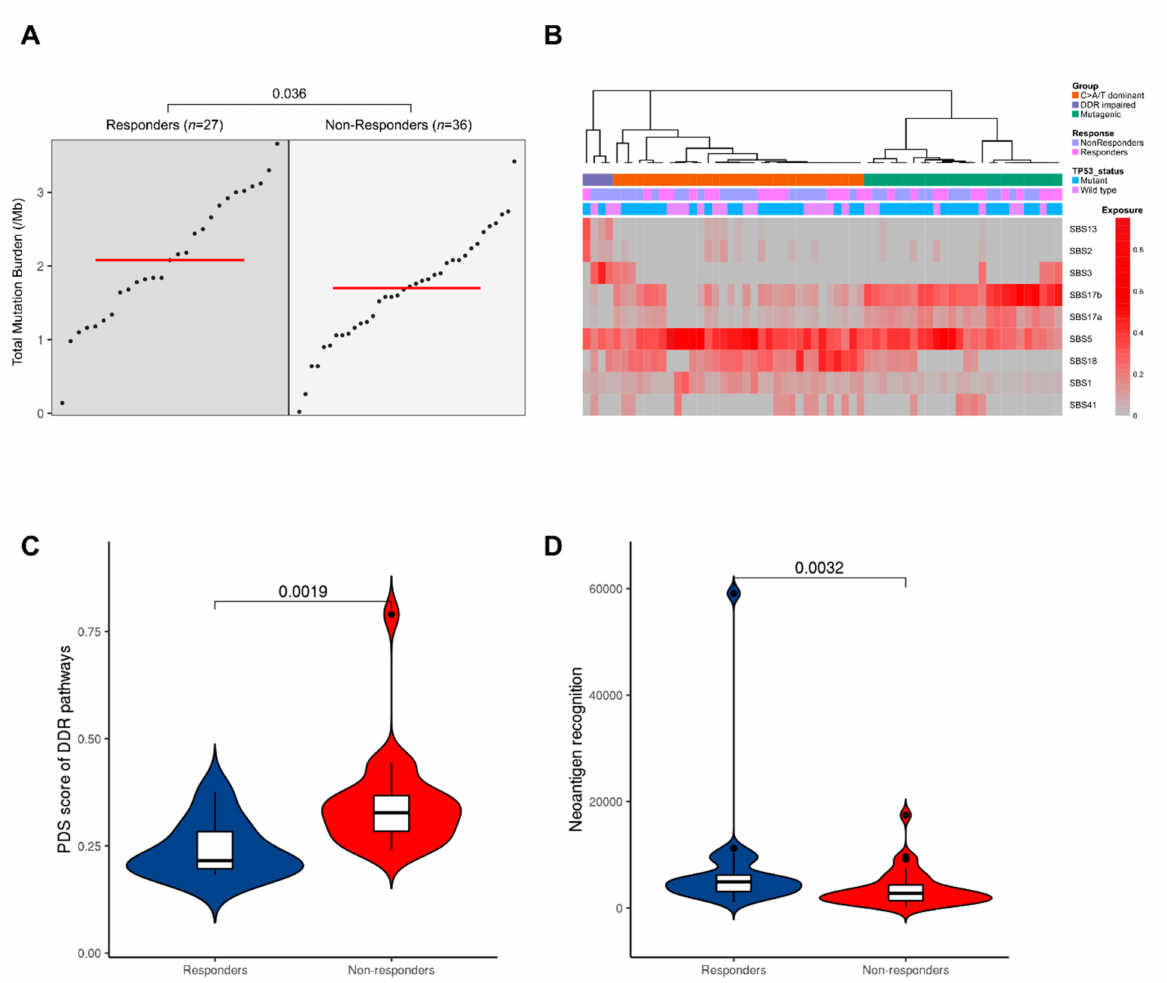
Figure 2. Mutational landscape of NAC response. Responders have a higher mutation burden and neoantigen recognition potential. ( A ) Group dot plot of mutation per megabase. Each dot represents a patient with the red line marking the group median. ( B ) Clustering of the nine mutational signatures in our patient samples as previously described by Secrier et al. [24]. ( C ) Pathway deregulation scores (PDS) calculated using gene expression values (log2 normalized) of available RNA-seq samples for DDR pathways. ( D ) Neoantigen recognition potential scores. Only neoantigens with recognition potential above 1 are